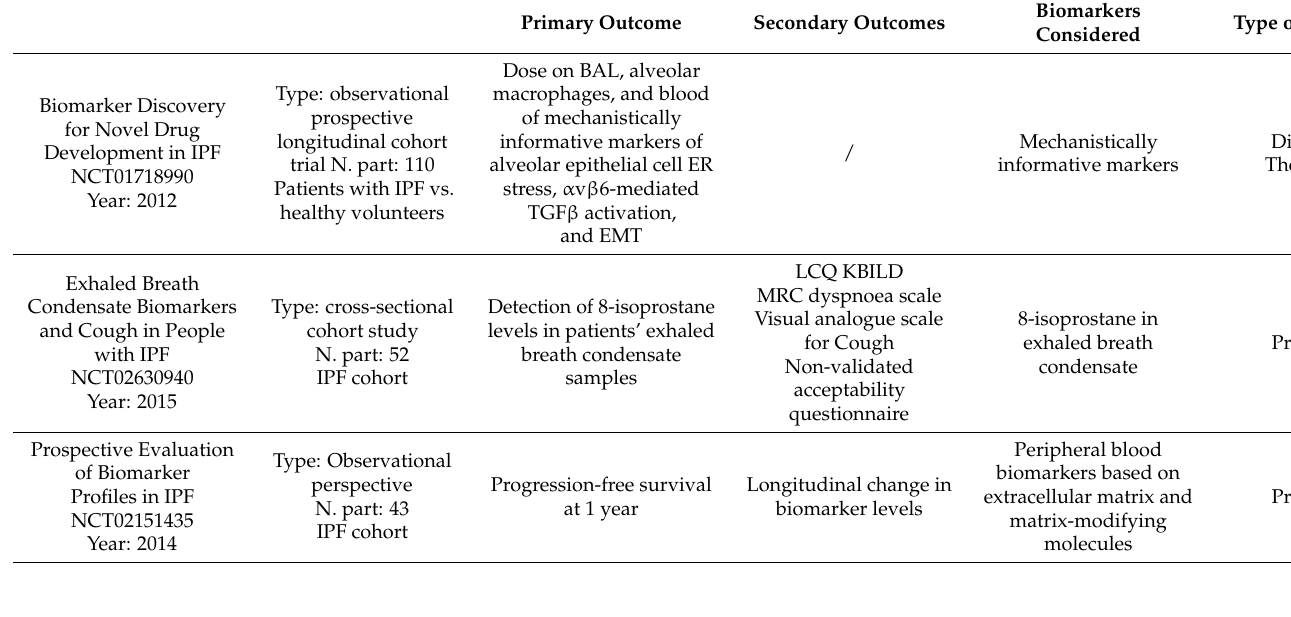
Table 2. Clinical trials on predisposition, diagnostic and prognostic biomarkers in